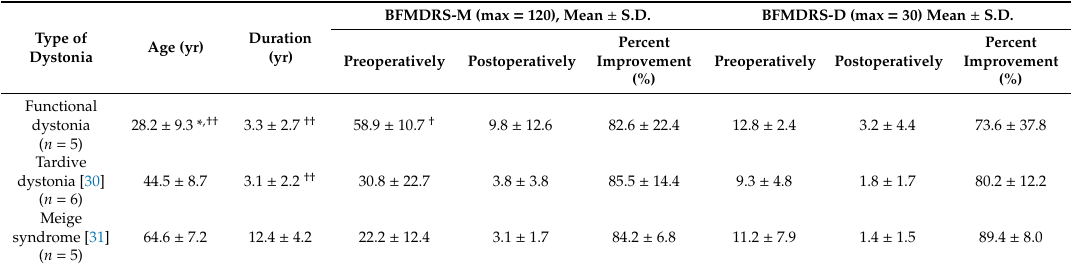
Table 3. Comparison of patients with functional dystonia, tardive dystonia, and Meige syndrome. BFMDRS-M (max = 120), Mean ± S.D. BFMDRS-D (max = 30) Mean ± Duration Type of (yr) Dystonia Age (yr)